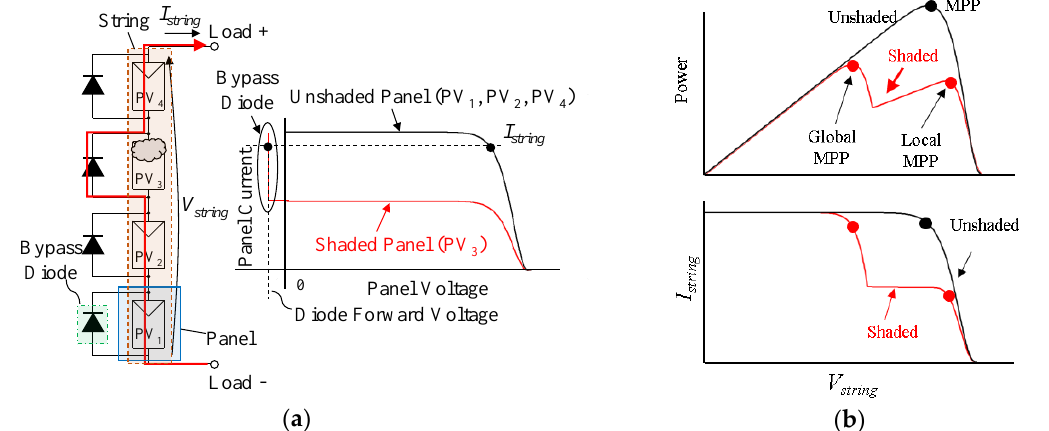
Figure 1. Characteristics under partial shading conditions: ( a ) Current path and panel characteristics; ( b ) String characteristics.